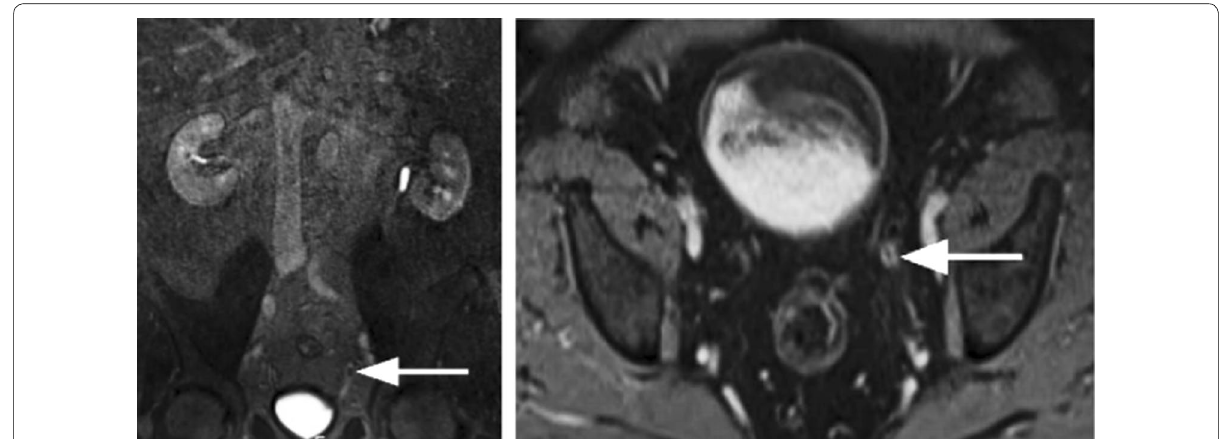
Fig. 5 Intraluminal filling defect (stone) in the distal left ureter detected by